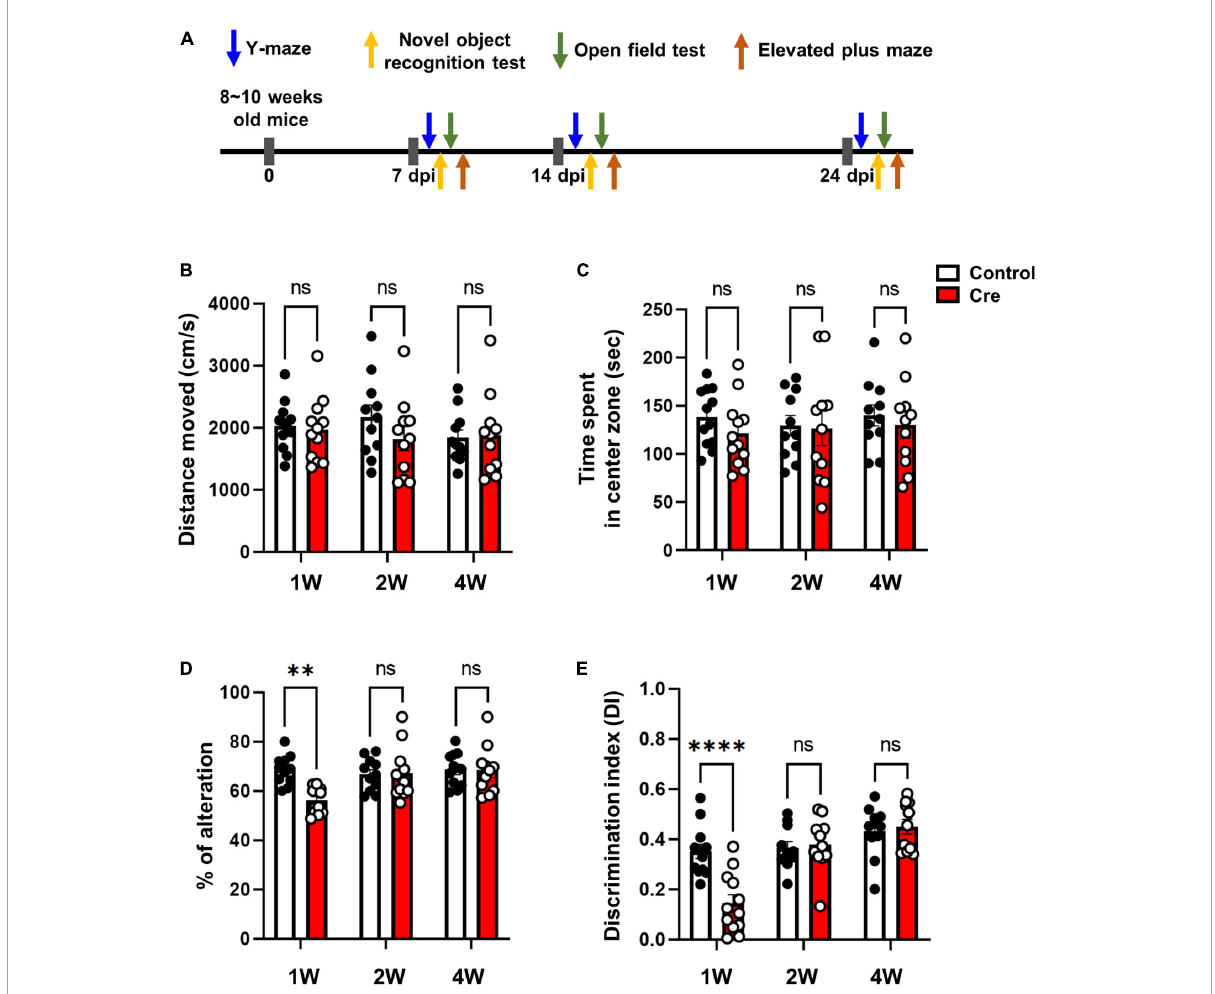
FIGURE4 Behavioral tests in hippocampal astrocyte-specific active caspase-3 cTg mice. (A) A diagram showing the timeline of behavioral experiments. (B) Measurement of total distance traveled in the open field test. (C) Measurement of the time spent in the center zone in the open field test. (D) Percentage of spontaneous alternation in the Y-maze test. (E) Rectification of index in the new object recognition test. Data are represented as the means ± SEM ( ∗∗ p < 0.01 according to two-way ANOVA and Turkey’s test, ns; not